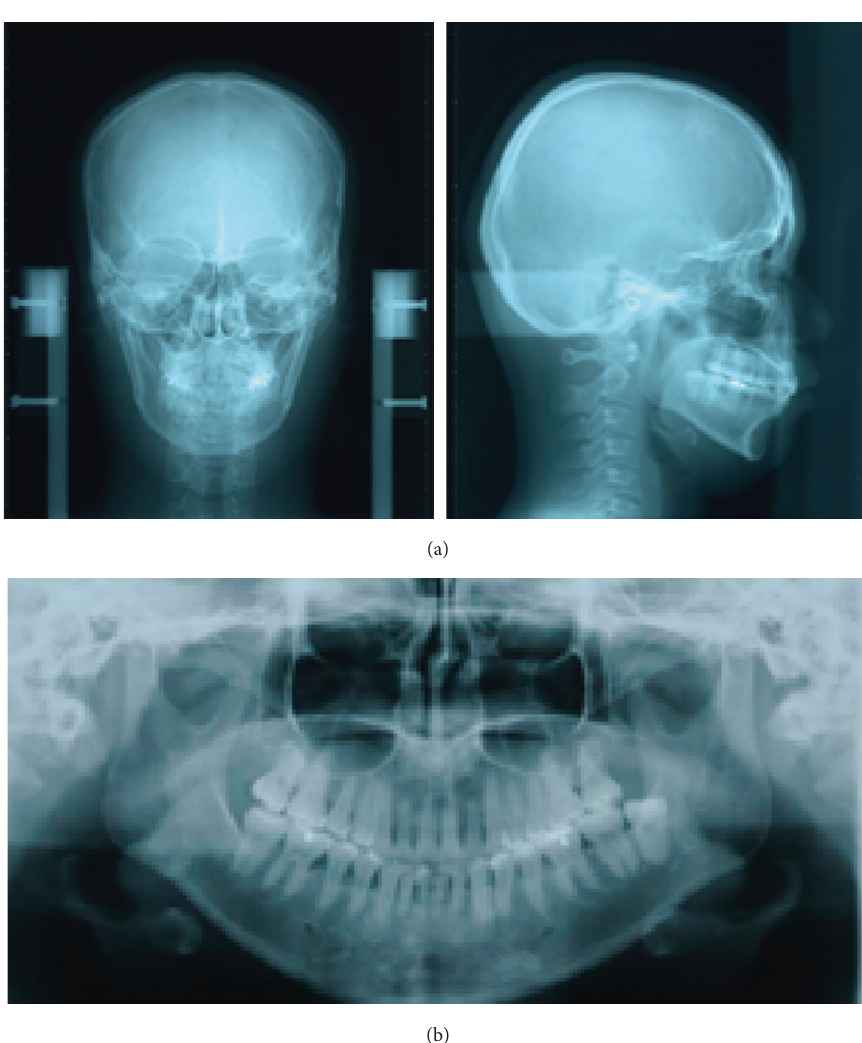
Figure 7: Post-orthodontic treatment cephalograms (a) and panoramic radiograph (b) are